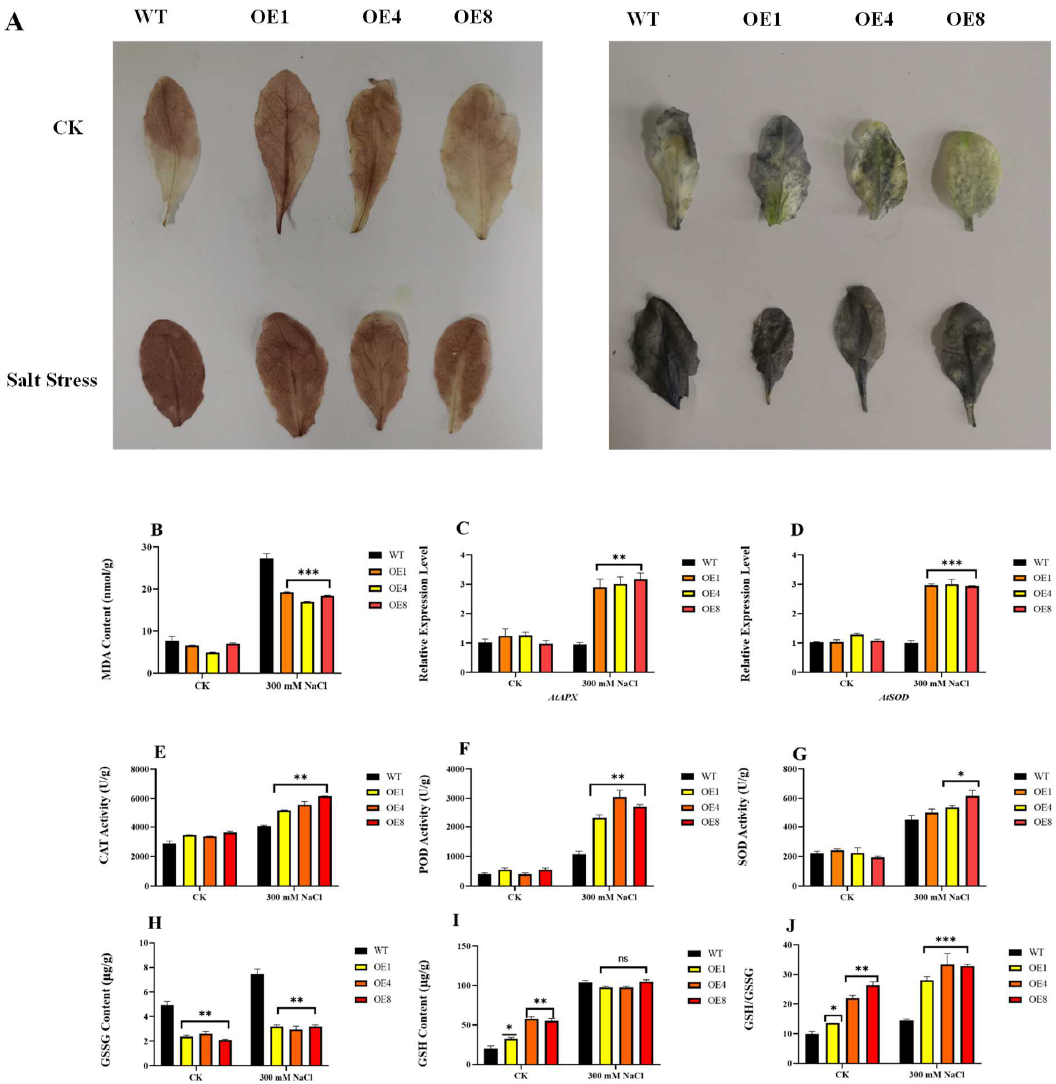
Figure 5. Oxidative damage indexes after overexpressing PcWRKY11 A. thaliana under salt stress. ( A ) Staining under salt stress in overexpressed PcWRKY11 plants. Leaves of transgenic and wild-type plants after DAB staining for H 2 O 2 detection under normal conditions and salt treatment. Leaves of transgenic and wild-type plants after NBT staining for O 2 − detection under normal conditions and salt treatment. ( B ) MDA content of transgenic and wild-type plants under normal conditions and salt treatment. ( C ) Relative expression analysis of AtAPX. ( D ) Relative expression analysis of AtSOD. ( E ) The enzyme activities of CAT. ( F ) The enzyme activities of POD. ( G ) The enzyme activities of SOD. ( H ) GSSG content of transgenic and wild-type plants under normal conditions and salt treatment. ( I ) GSH content of transgenic and wild-type plants under normal conditions and salt treatment. ( J ) GSH to GSSG ratio of transgenic and wild-type plants under normal conditions and salt treatment. The mean values and standard errors were calculated with three independent experiments. *, **, and *** represent a significance level of p < 0.05, p < 0.01, and p < 0.001 respectively; ns, p > 0.05, no significant difference; WT, wild-type plants; OE, overexpressed plants CK, under normal